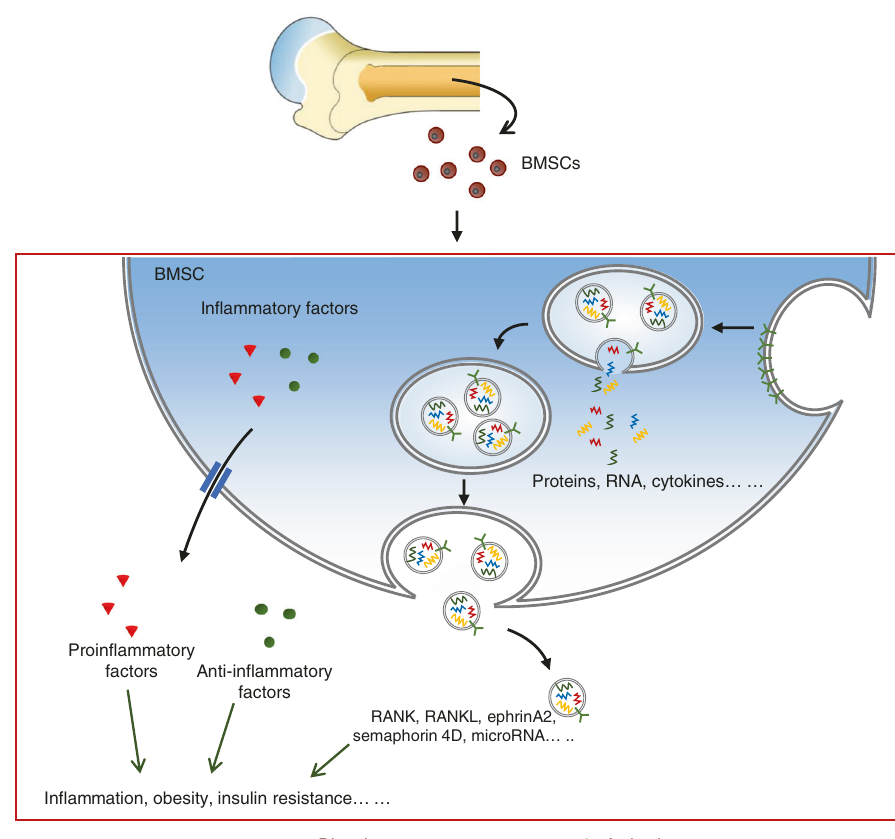
Fig. 3 Exosomes and in fl ammatory factors are mainly secreted by BMSCs. After forming vesicles containing various active substances, exosomes are released into the extracellular matrix. The in fl ammatory factors released by BMSCs can be divided into proin fl ammatory factors and anti-in fl ammatory factors. Exosomes and in fl ammatory factors can regulate distant target organs, thus leading to an in fl ammatory response, obesity, insulin resistance,